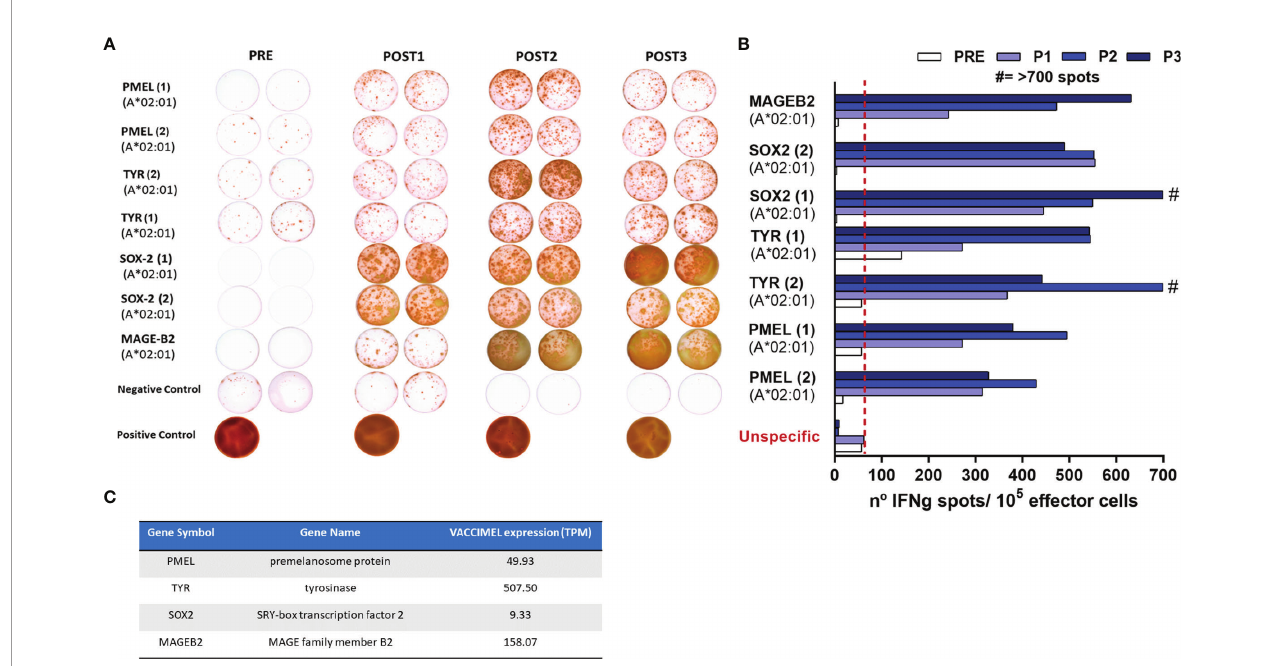
FIGURE 3 | Patient #5 immune response to common melanoma antigens. (A) T-cell response induced by VACCIMEL to HLA-A0201-restricted peptides from shared melanoma-associated antigens detected by IFN- g ELISPOT. Pre: blood extracted at the selection process; Post 1, Post 2, and Post 3: blood extracted 6, 12, and 25 months after protocol start. (B) Quanti fi cation of the spots normalized to 10 5 PBMC (right panel). (C) PMEL, tyrosinase (TYR), SOX-2 and MAGE B2 antigens abundance in VACCIMEL as determined by RNA-Seq and normalized in